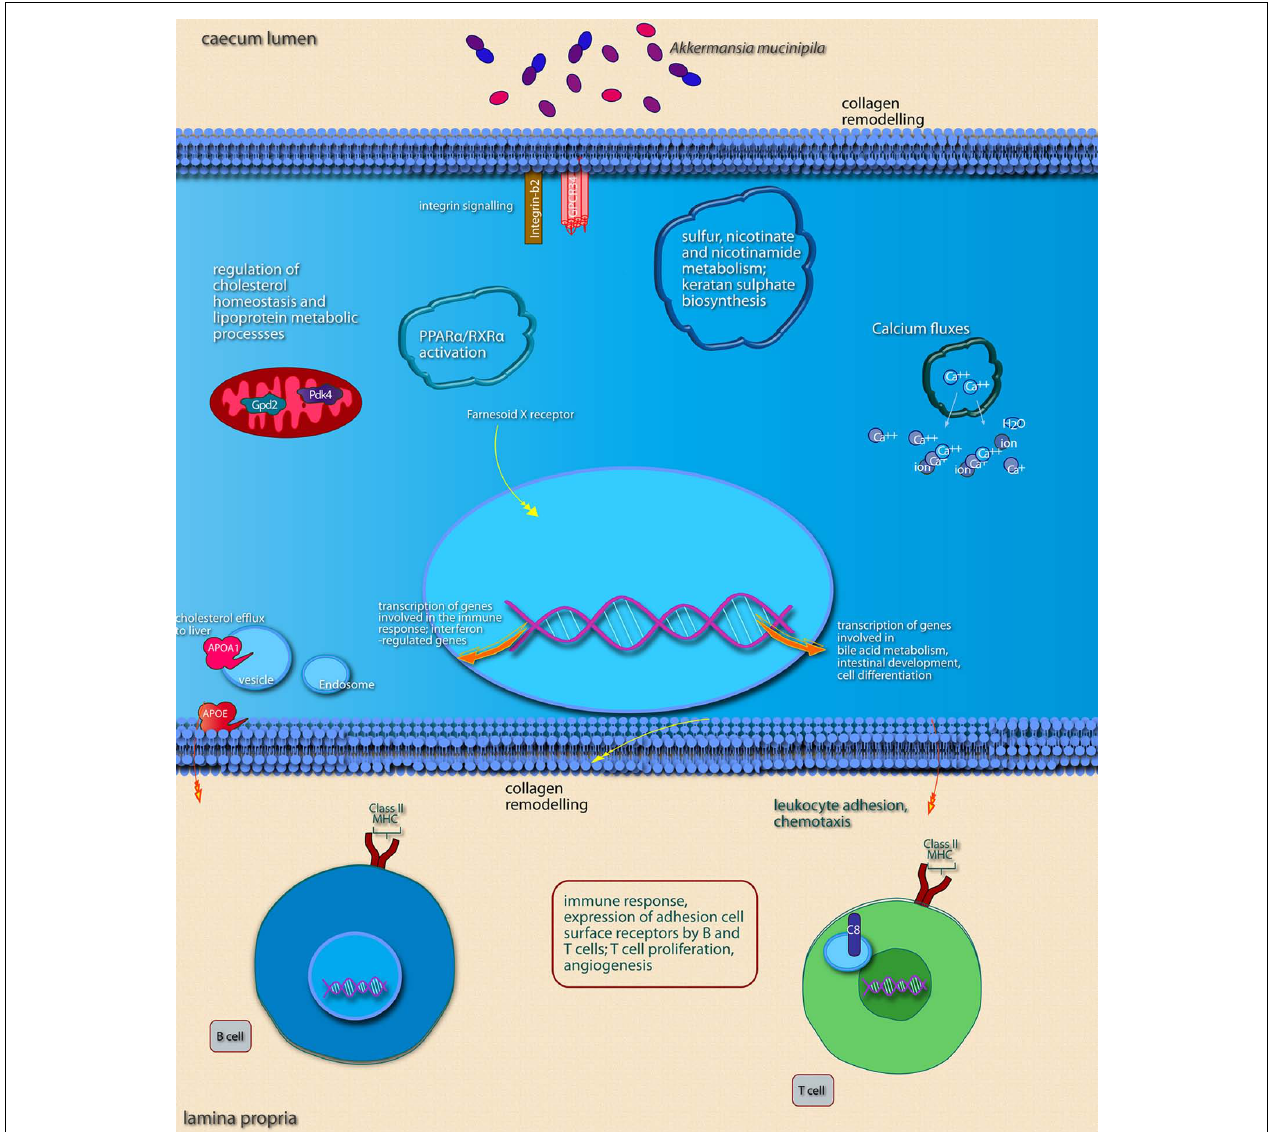
non-specific localization. Pathways and processes named in text “balloons” were among the most significantly modulated pathways according to IPA canonical pathway analysis.The lower part of the image shows pathways known to be regulated in immune cells of the lamina propria. In order to determine in which cell type and subcellular compartment a gene product was localized, the Entrez Gene GO annotation, Entrez Gene GeneRIFs, and scientific literature information were used. Interacting pathways and processes are grouped together as well as possible, both in terms of annotation as well as within the graphical space